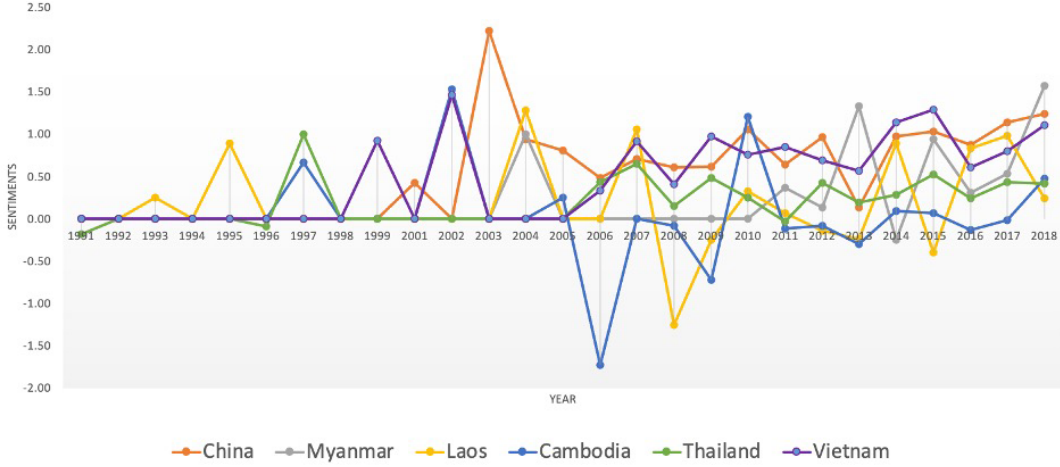
Figure 8. Conflict and cooperative sentiment scores of the riparian countries (Cambodia, China, Laos, Myanmar, Thailand, and Vietnam) from 1991 until